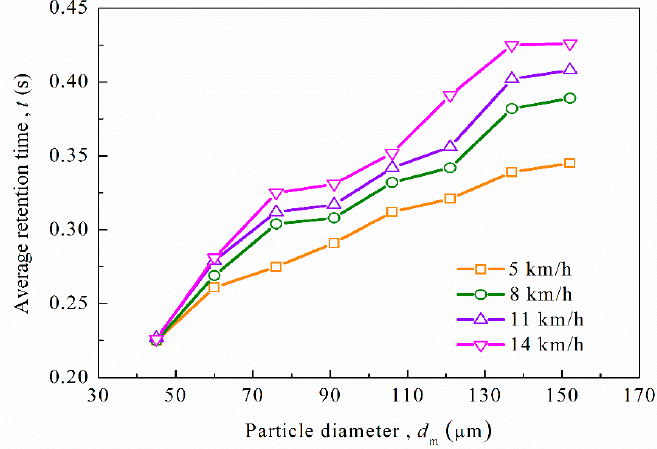
Figure 15. Influence of traveling speed on the average retention time.